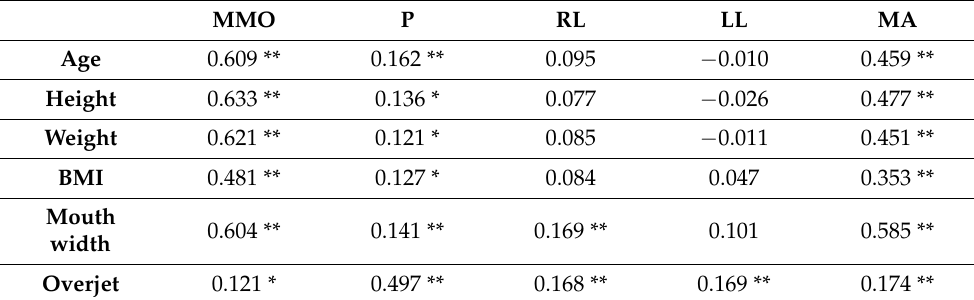
Table 2. Correlation coefficients between mandibular range of motion and mouth area with age, height, weight, body mass index, mouth width and